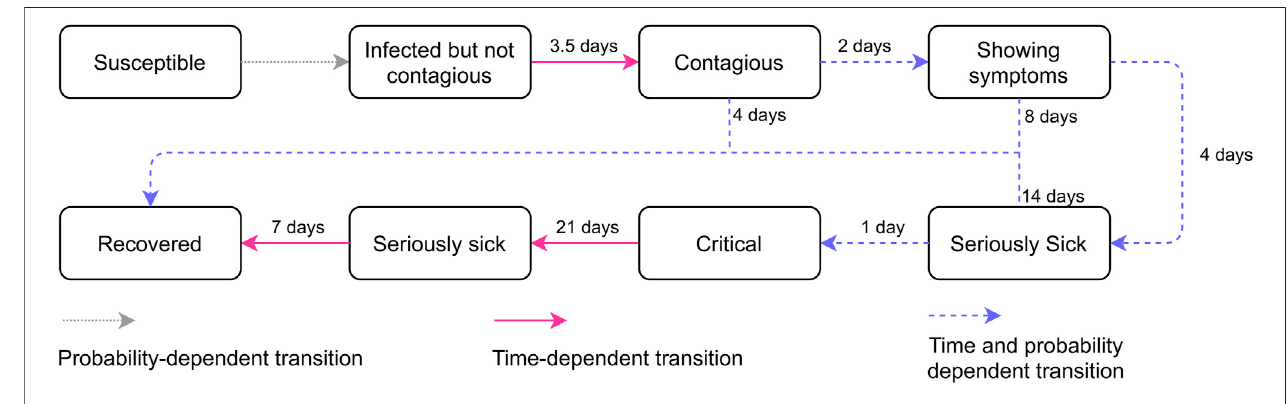
FIGURE 2 | EPISIM progression model of COVID-19.